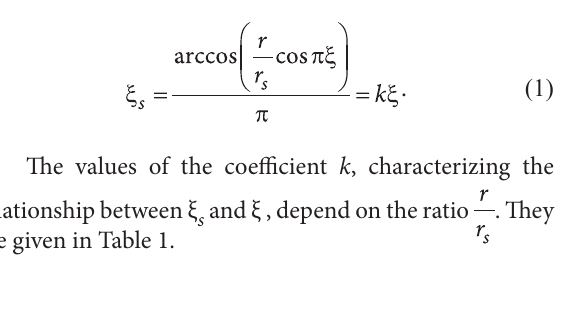
As shown by the data given in Table 1, the difference and ξ is the greatest, when the ratio incre- between ξ s